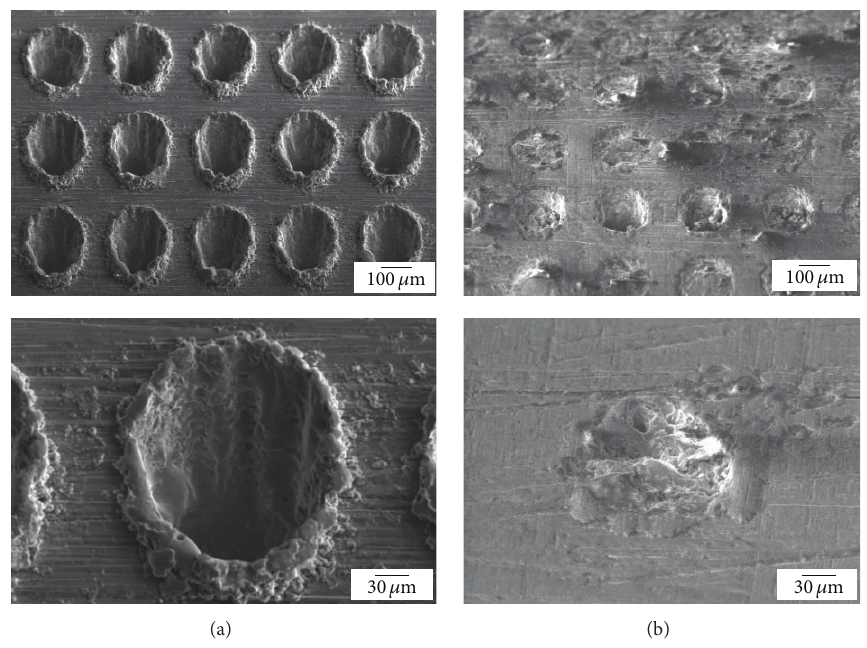
Figure 14: SEM images of die radius—texture #2: (a) before and (b) after hot stamping